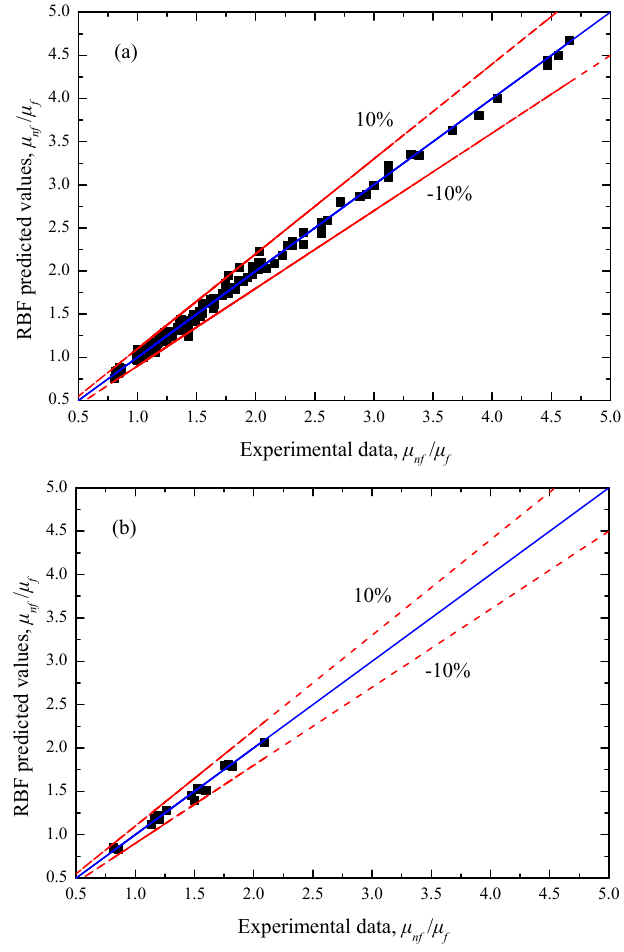
Figure 5. Scatter plots of ( a ) training and ( b ) testing μ nf / μ f for the RBF predicted results and experimental data.